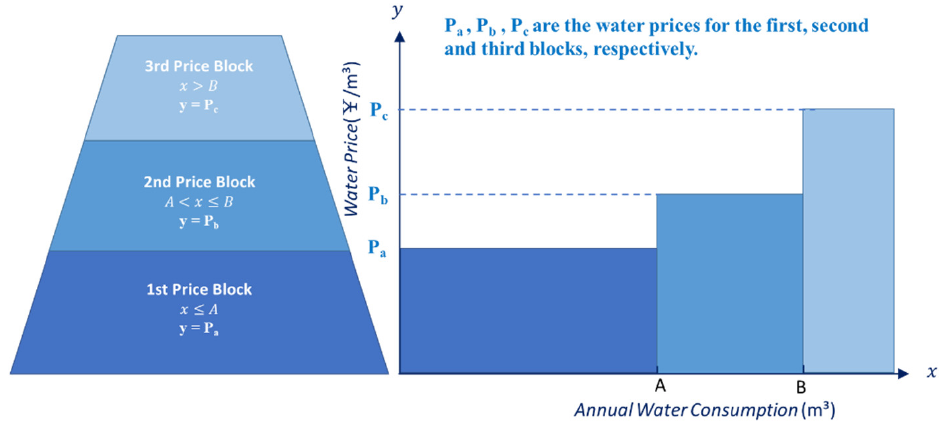
Figure 1. Increasing-block water rate for residential water use with three price blocks.